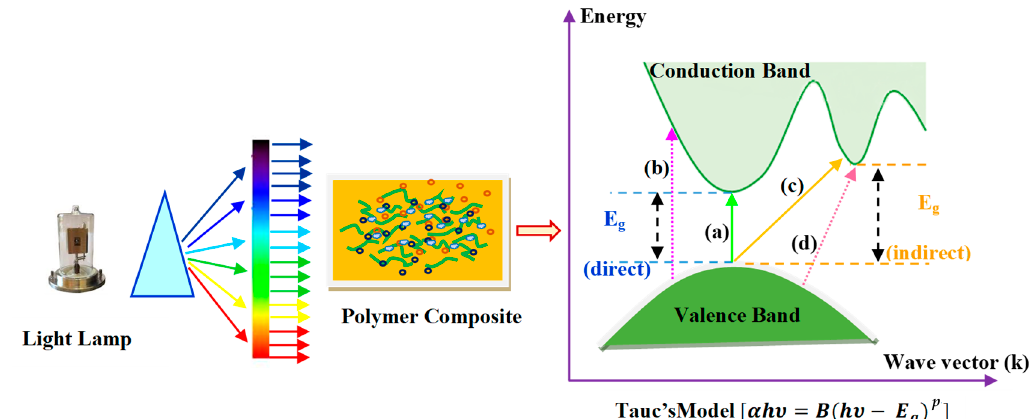
Figure 9. Illustration of possible electronic transitions (a) direct allowed, (b) direct forbidden, (c) indirect allowed, and (d) indirect forbidden [44,59] .